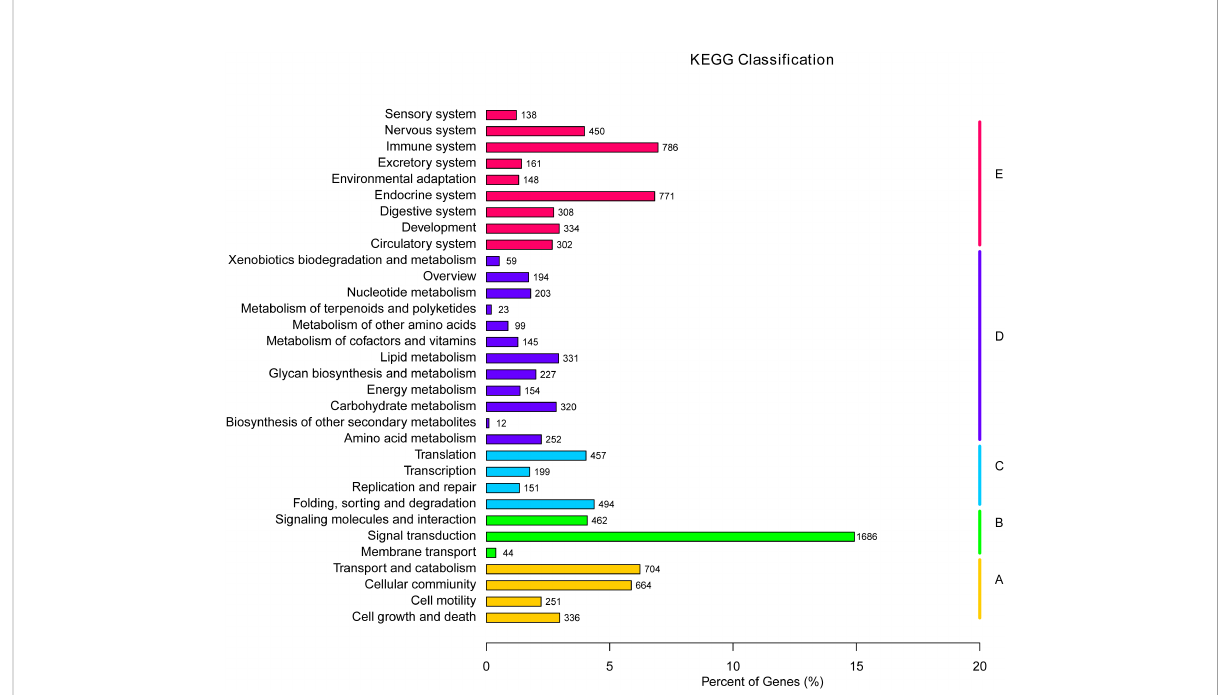
FIGURE 7 KEGG pathway assignment of the assembled unigenes. Different colored bars represent different groups.